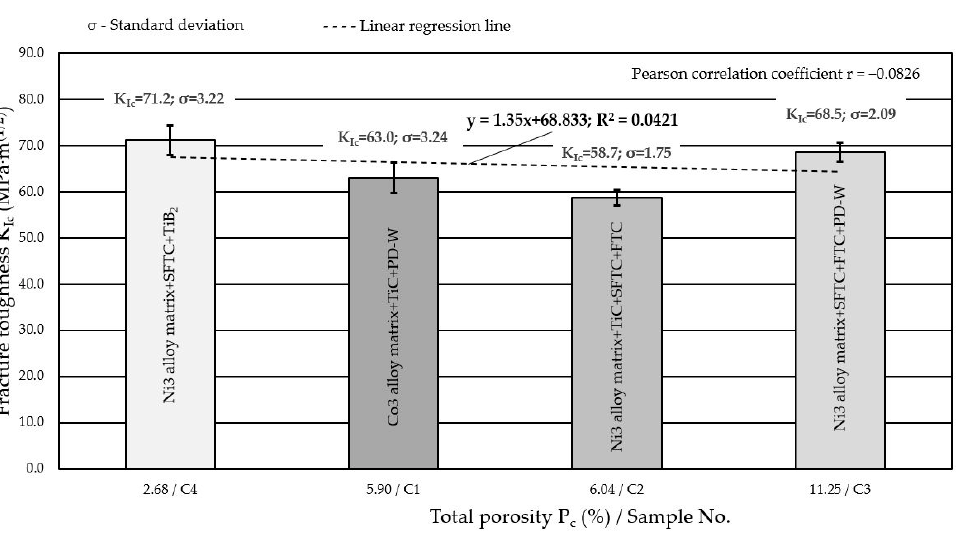
Figure 14. Influence of porosity of composite layers on the critical value of the stress intensity factor K Ic .